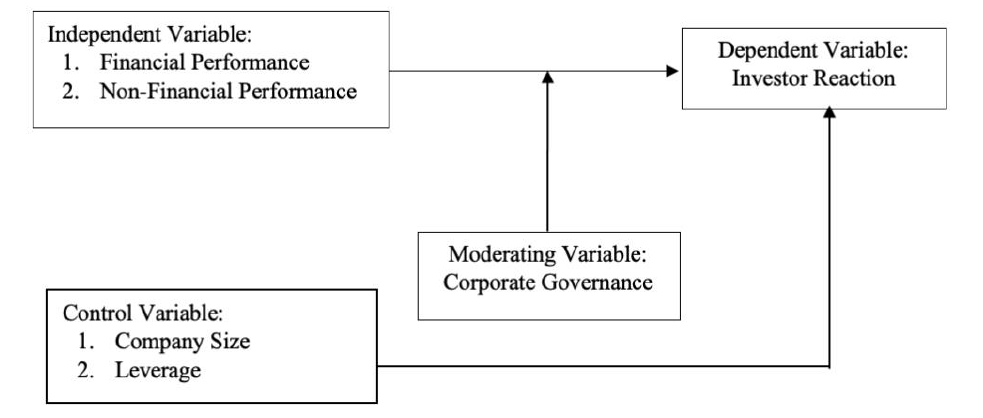
Figure 1: Research Conceptual Framework; Source: